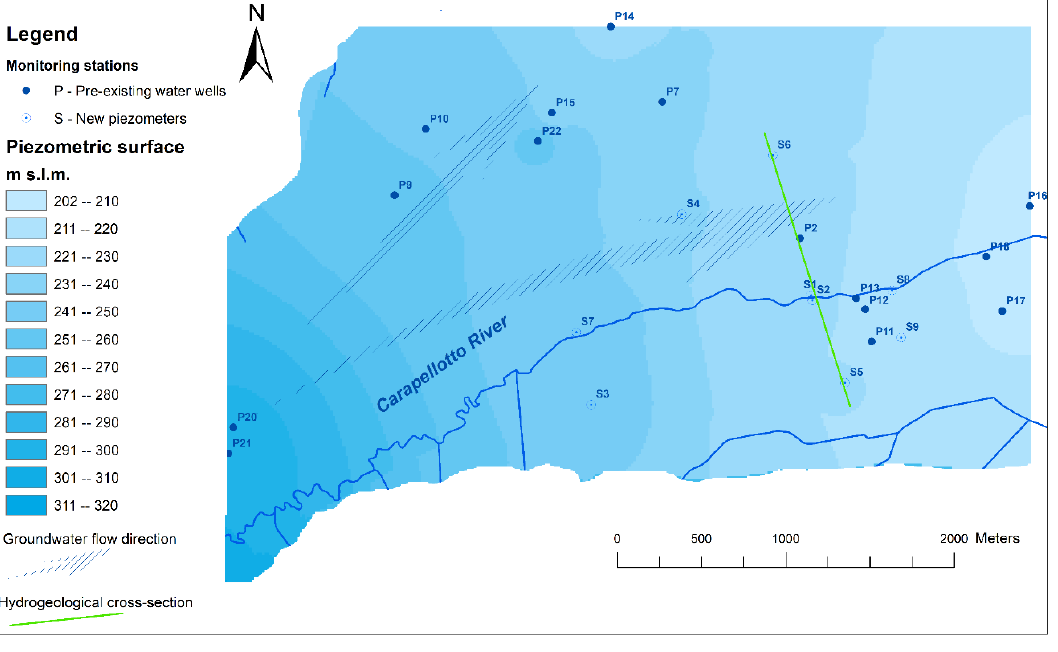
Figure 10. Piezometric map of the study area.